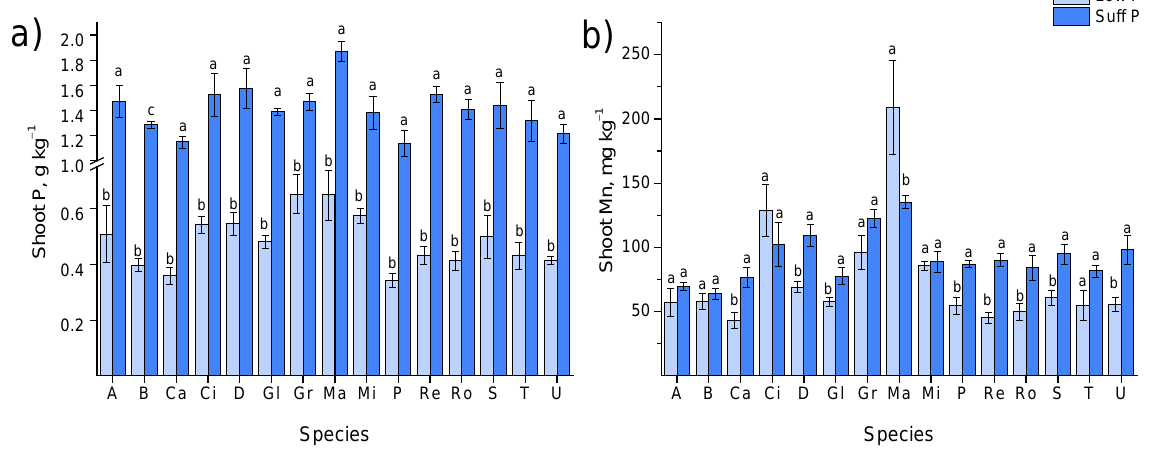
Figure 2. Concentration of phosphorus ( a ) and manganese ( b ) in shoots of fifteen eucalypt species grown under low (Low P, clear color) and sufficient (Suff P, dark color) phosphorus concentrations. Different letters indicate significant differences between low and sufficient P concentrations within each species by the Tukey test ( p < 0.05). Species abbreviations: A— E. acmenoides , B— E. brassiana,